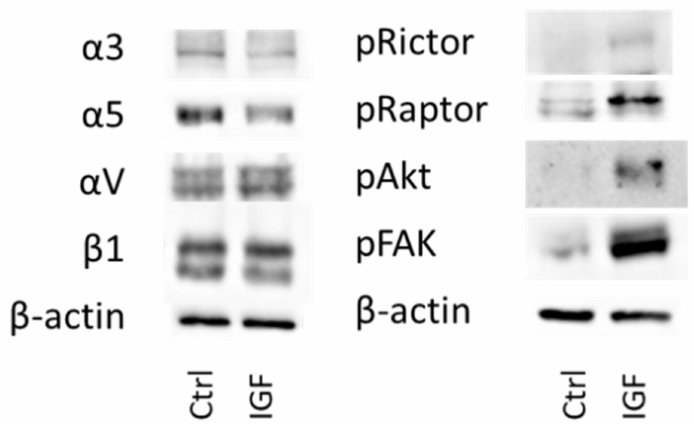
Figure 10. Left: protein profile of integrins α 3, α 5, α V, and β 1 in PC3 cells. Right: protein profile of cell signaling proteins in PC3 cells. DU145 or PC3 cells were either stimulated with IGF for 24 h or received culture medium without IGF (Ctrl). One representative of three separate experiments is shown. Each protein analysis was accompanied by a β -actin loading control. One representative internal control is